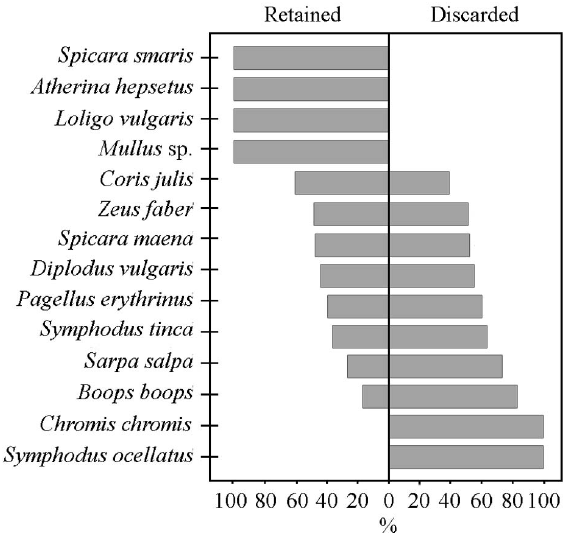
Fig . 6. – Comparison of the retained and discarded portions of the catch for the most important species (estimation based on number of